Question: According to this chart, does the measure grow or shrink?
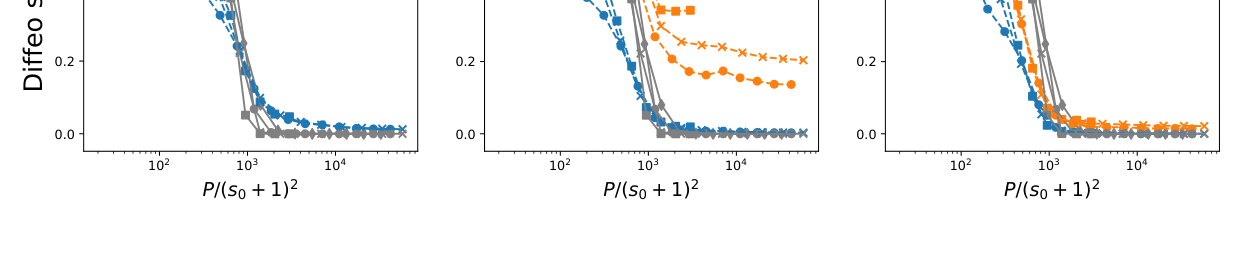
Answer: increasing